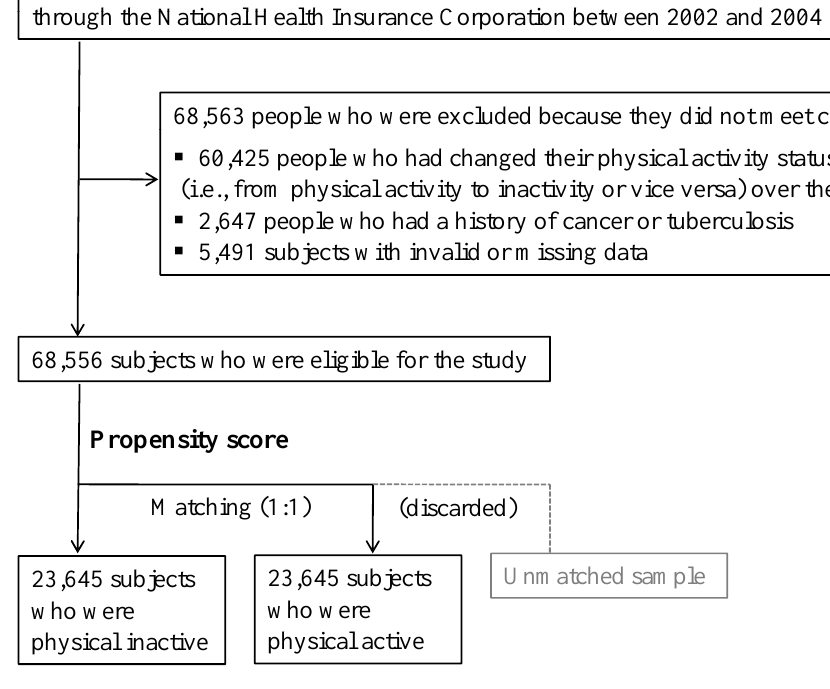
Figure 1. Flow chart of study population